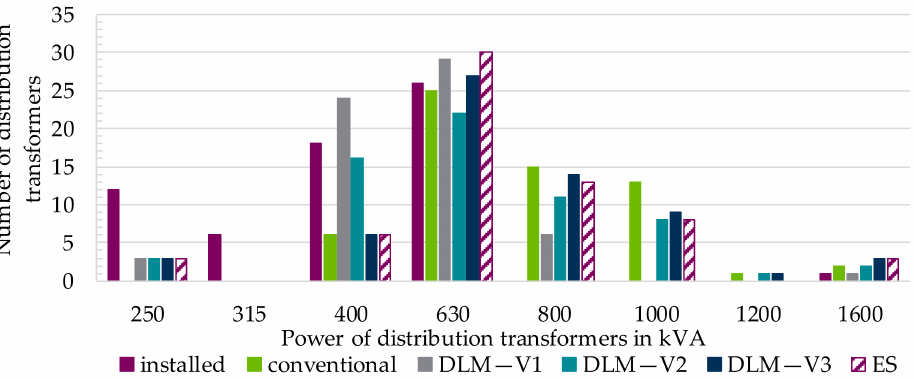
Figure 32. Necessary increases in the power classes of local distribution transformers for 18 consoli- dated grids in the presence of limit